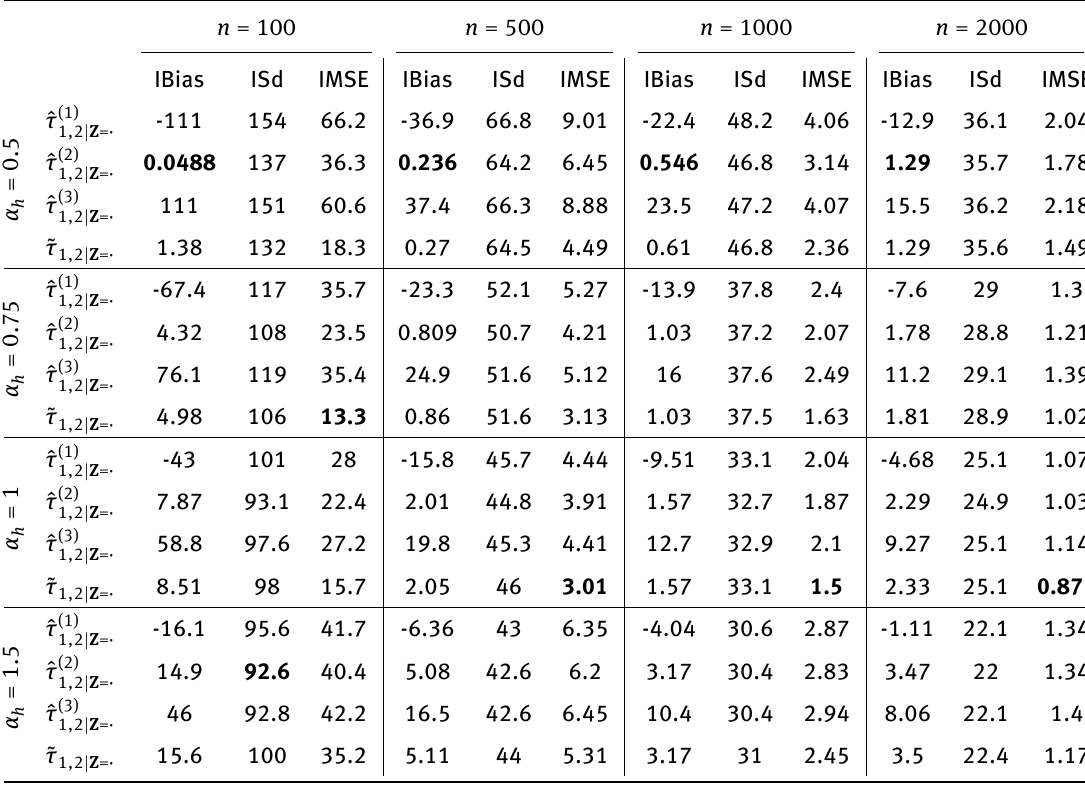
Table 3: Results of the simulation in Setting 2 using h = α h × h CV where h CV has been chosen by cross-validation. All values have been multiplied by 1000. Bold values indicate optimal choices for the chosen measure of performance.